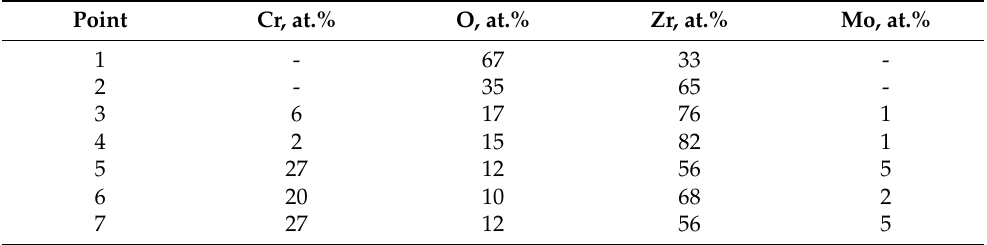
Figure 9. Cross-section SEM image of the Cr/Mo-coated Zr alloy sample after LOCA oxidation at 1400 °C for 120 s. Table 6. Elemental composition of the Cr/Mo-coated Zr alloy sample after LOCA oxidation at 1400 °C for 120 s.